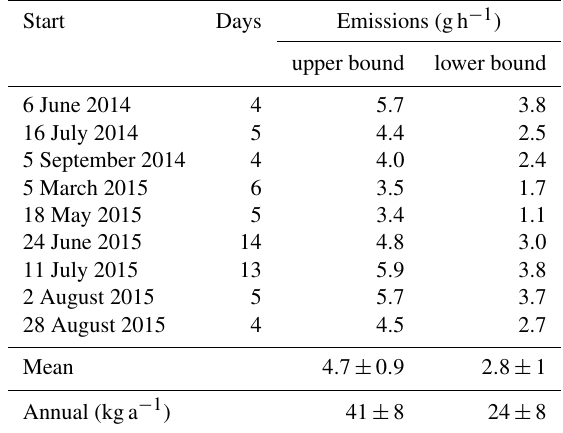
Table 1. The emission estimates of GEM in Zurich, Switzerland, are shown for all nine observed summer periods.